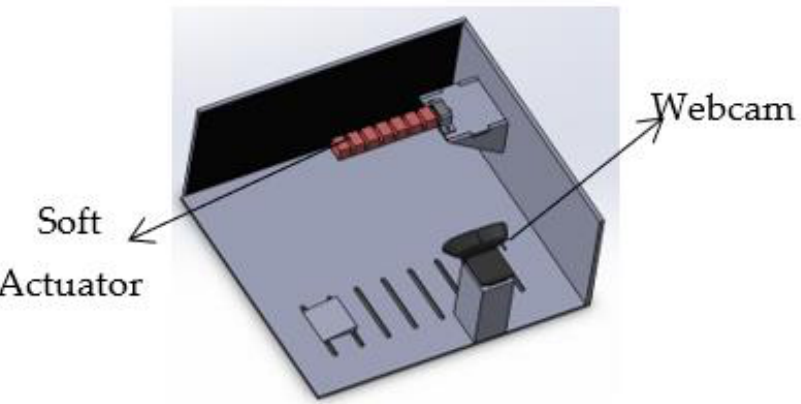
Figure 7. Test rig for measure bending angle values for SPA and compare it with webcam readings.